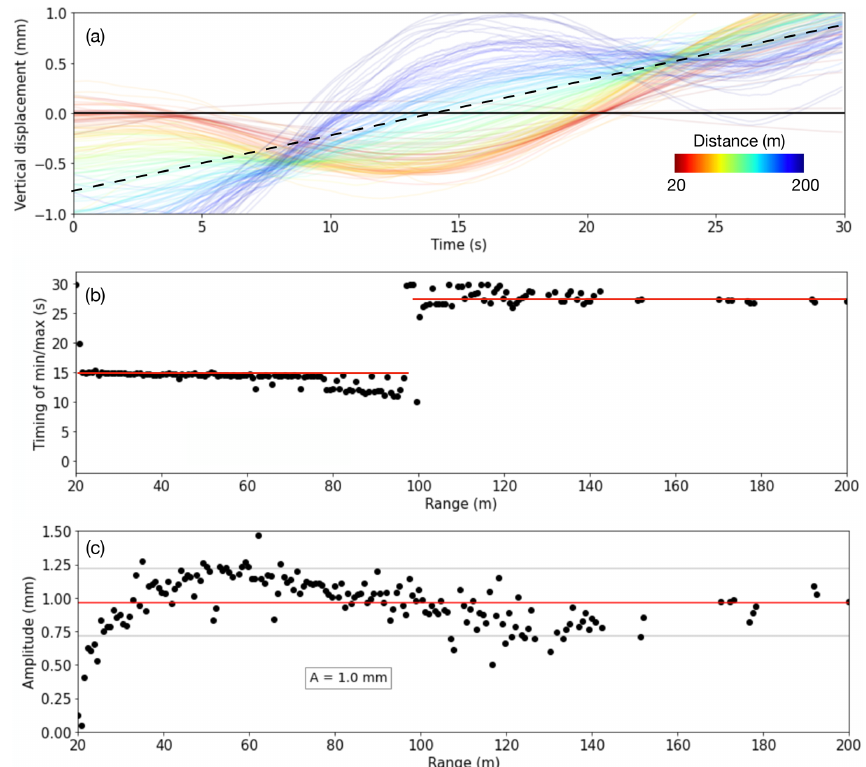
Figure 10. (a) Derived vertical displacement over 30s on 23 April 2021 at 22:32UTC (E2). Each line represents one location on the ice, where warmer colors signify a distance closer to the radar. The dashed line indicates a linear trend removed for the analysis. (b) Exact time of the trough at different distances from the radar. The red lines indicate average values on each side of the node. (c) Amplitude with range with the red line indicating the